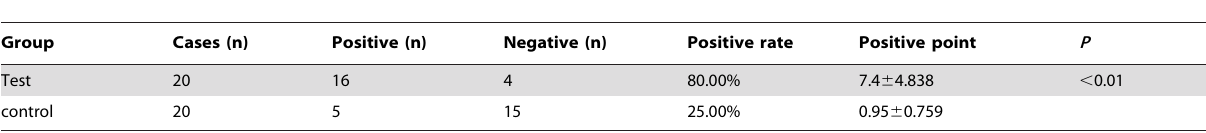
Table 1. The expression of Pokemon protein in HCC.